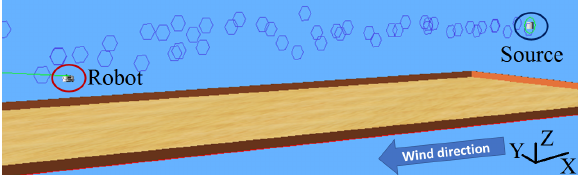
Figure 4. Simulation environment in Webots, with the source upwind, the robot downwind, and the odor patches represented with blue hexagons.